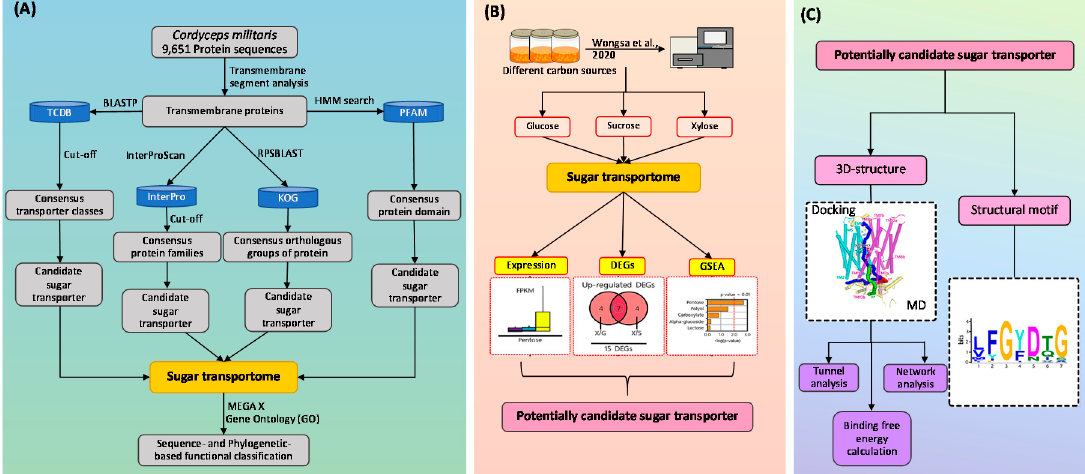
Figure 1. Systematic workflow of integrative analysis of sugar transportome, global transcriptome and protein structure in Cordyceps militaris . Note: ( A ) The construction of sugar transportome by transmembrane segment analysis and consensus features identification against C. militaris genome [18]; ( B ) integrative analysis of sugar transportome and global transcriptome data through differentially expressed genes (DEGs) identification and gene set enrichment analysis (GSEA) across different carbon sources for identifying a candidate sugar transporter; ( C ) the three-dimensional (3D) structural analysis and structural motif analysis of the targeted transporter. The 3D-structural analysis includes modeling, docking and molecular dynamics (MD) simulation, followed by tunnel, network, and binding free energy analysis.